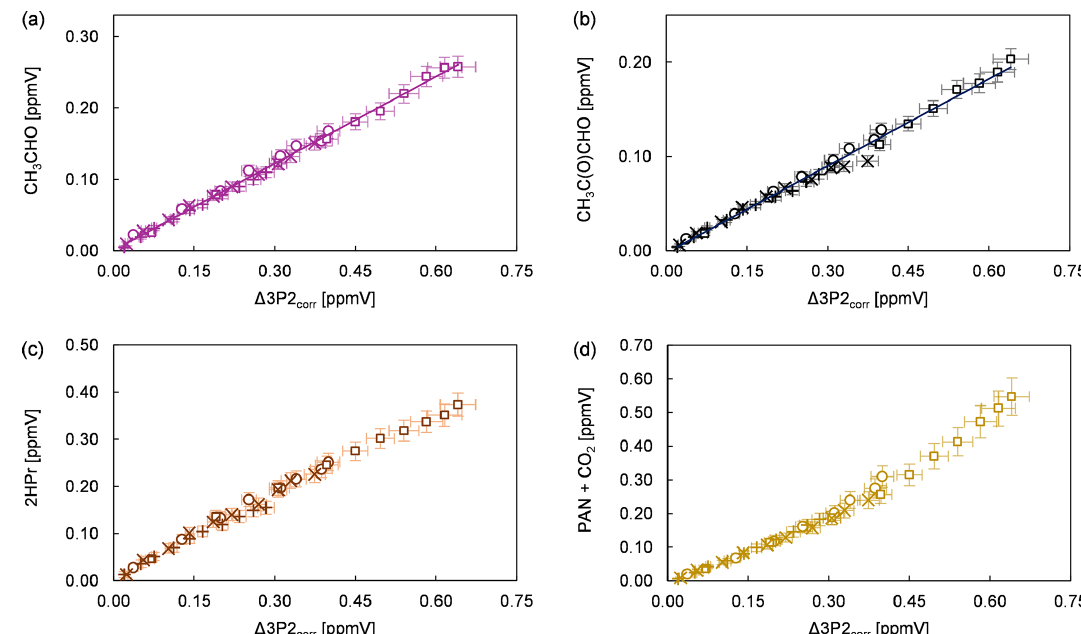
Figure 3. Yield plots for (a) acetaldehyde, (b) methyl glyoxal, (c) 2-hydroxypropanal, and (d) the sum of PAN and CO 2 for all conducted experiments corrected for the wall loss of 3P2. The error bars consist of the corresponding precision error. The data of the 480L chamber experiments are multiplied with a factor of 0.1 to fit within the scale of 1080L chamber experiments. Different experimental runs are denoted with different